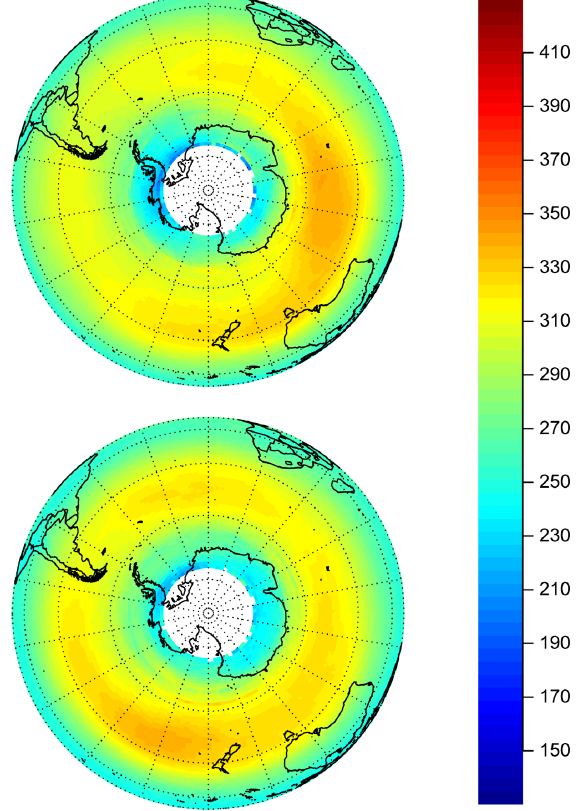
Fig. 4. Southern Hemisphere seasonal mean column ozone (in DU) during austral winter (JJA) for 1986–1989. Top: seasonal mean of 1988 and 1989 representing a strong La Ni˜na phase (shifted, partly opened and locally enriched ozone “collar”). Bottom: sea- sonal mean of 1986 and 1987 representing a strong El Ni˜no phase (closed, ozone-rich and homogeneous ozone